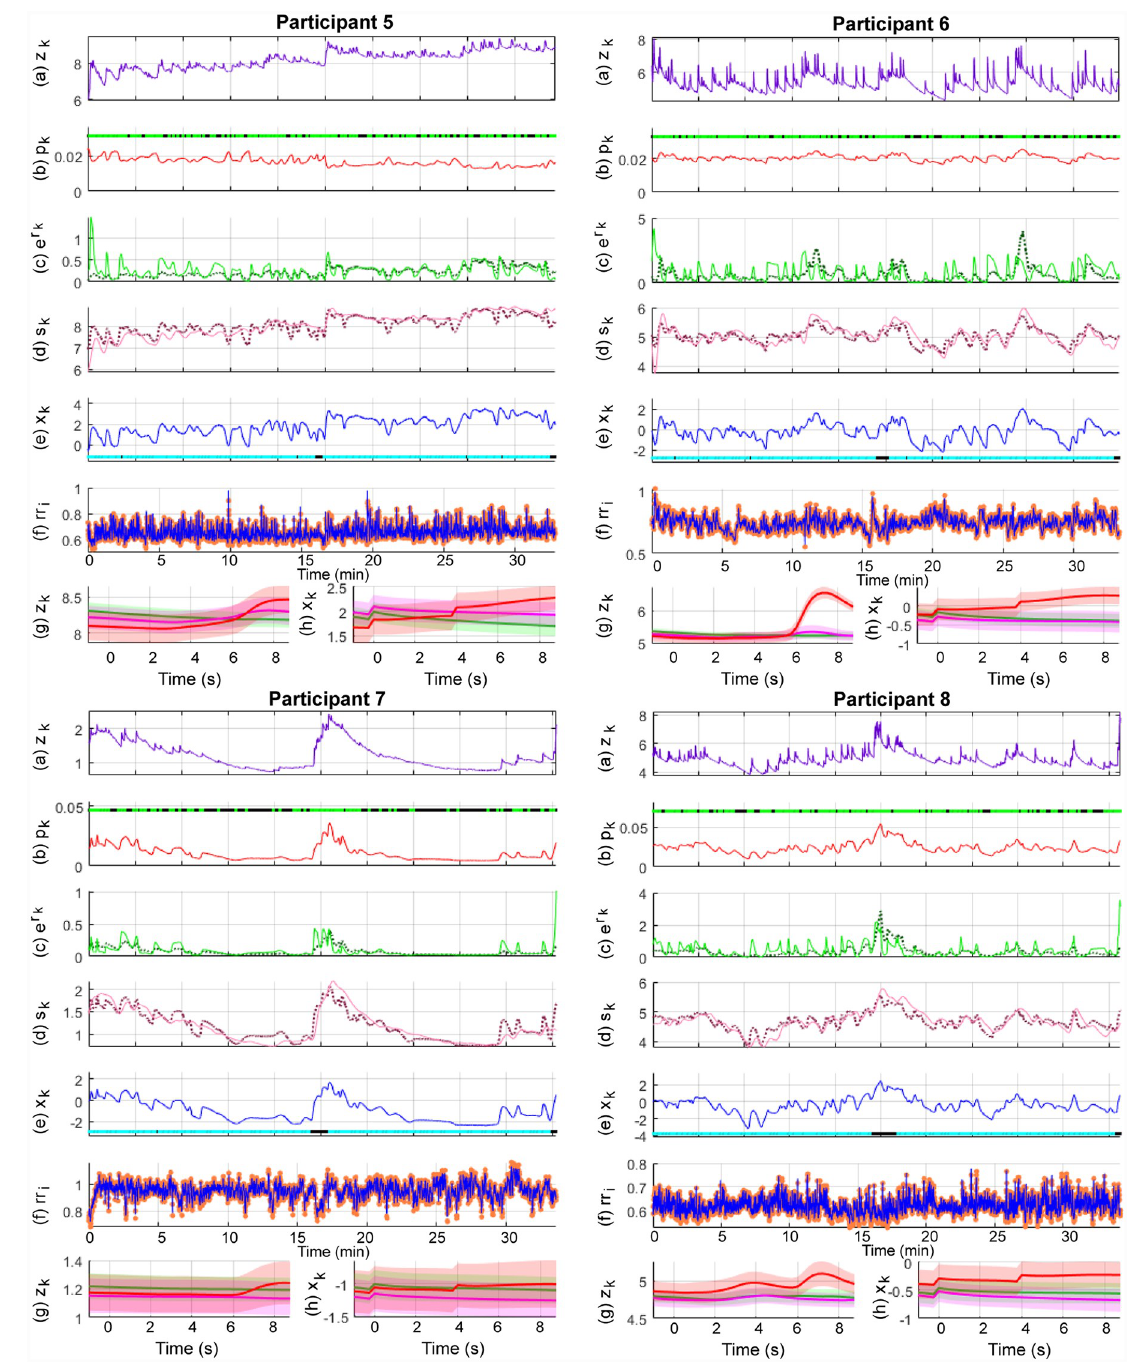
Fig 9. Sympathetic arousal estimation for participants 5-8 in the trace fear conditioning experiment. The sub-panels from top to bottom respectively depict, (a) the skin conductance signal z k ; (b) the presence or absence of SCR peaks (light green and black dots) and the (red line); (c) the exponent of the phasic derived signal r (solid green line) and its smoothed Bernoulli trial probability estimates of p k k estimate (dotted line); (d) the tonic part s k (solid light mauve line) and its estimate (dotted line); (e) the smoothed arousal state estimates of x k and the presence or absence of visual or electric stimuli (cyan and blacks dots); (f) the sequence of RR-intervals rr i (orange dots) and the estimated RR-interval mean μ (solid blue line); (g) a 10 s ERP-like skin conductance plot for the CS- (green), CS+ without a shock (mauve —CS+US-) and CS+ with the shock (red—CS+US+) trials; (h) 10 s ERP-like arousal state plots along with their confidence intervals.